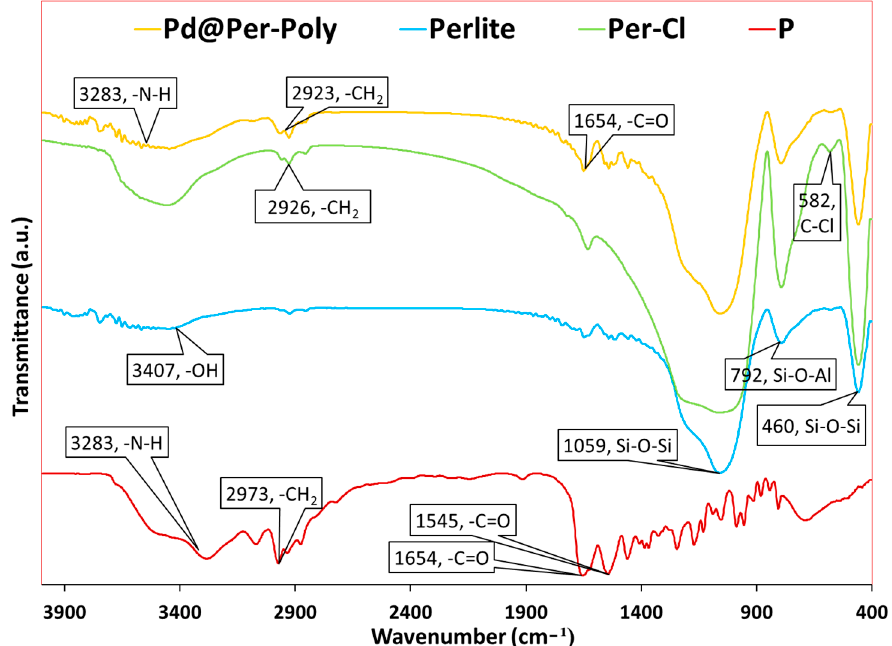
Figure 7. FTIR spectra of Per, Per–Cl, P, and Pd@Per-P.